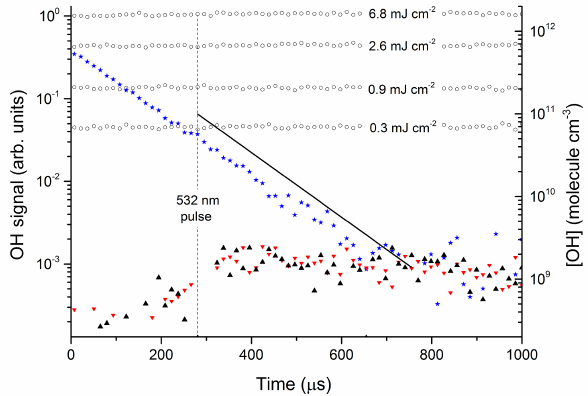
Figure 3. Photoexcitation of NO 2 at 532nm. The open circles are OH calibrations obtained by the 193nm photolysis of 1 . 5 × 10 17 moleculecm − 3 H 2 O (in the absence of NO 2 ) at different laser fluences (mJcm − 2 ). The solid stars are data points from an OH calibration in the presence of NO 2 . The black triangles are data obtained by photoexcitation of [NO 2 ] = 4 . 0 × 10 15 moleculecm − 3 using 532nm (50mJcm − 2 ) in the presence of [ H 2 O ] = 1 . 5 × 10 17 moleculecm − 3 . The red triangles are the results of an identical experiment, but with the OH-excitation laser tuned away from the OH feature at 282nm. The solid black line represents the OH signal and concentration expected from the yield of OH from NO ∗ reported by Li et al.